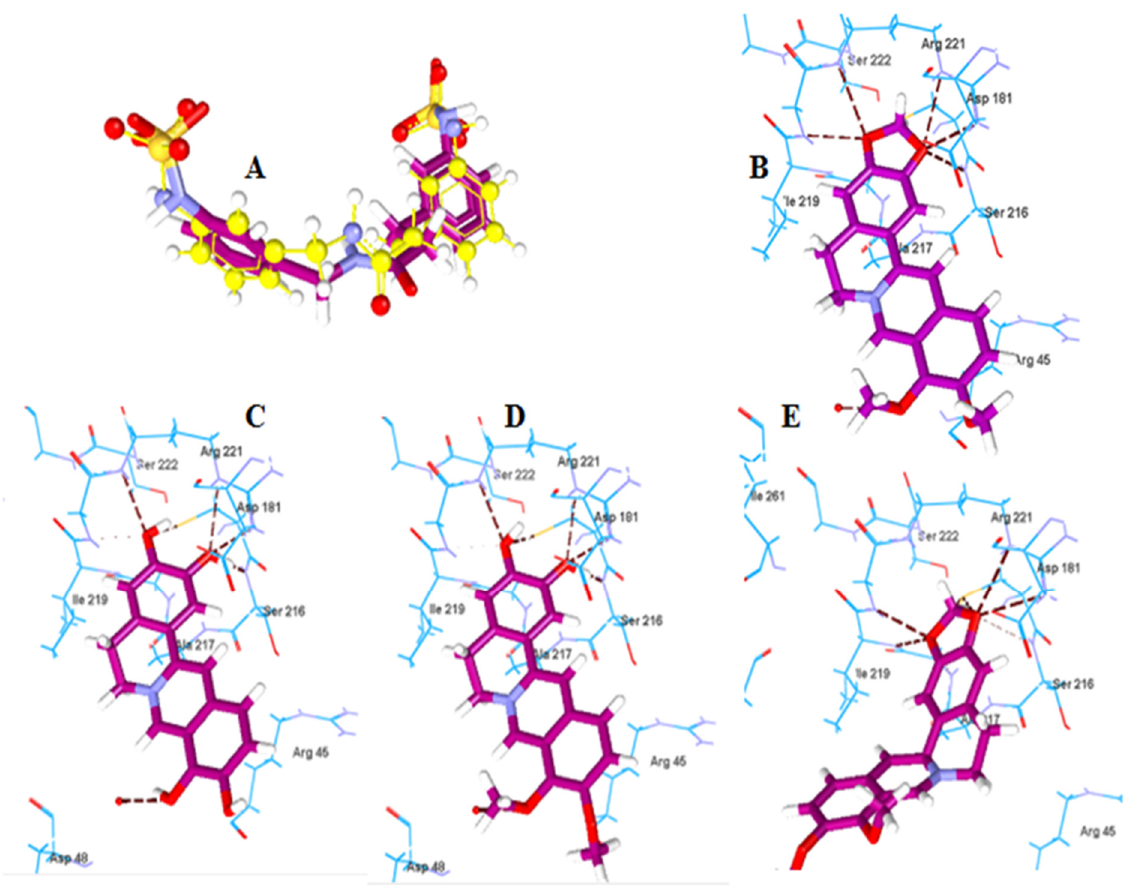
Figure 4. ( A ) Superimposed co-crystalized and redocked poses of 2F70 in PTP-1B. ( B – E ) Amino acid residues involved in ligand interaction shown as dashed lines with berberine, berberine metabolites 5 , 6 , and 7 , respectively.